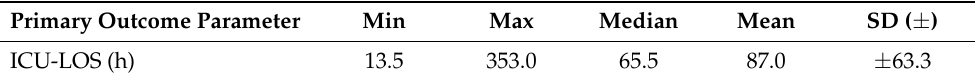
Table 3. Overall distribution of ICU-LOS ( n = 122) (SD: Standard Deviation).